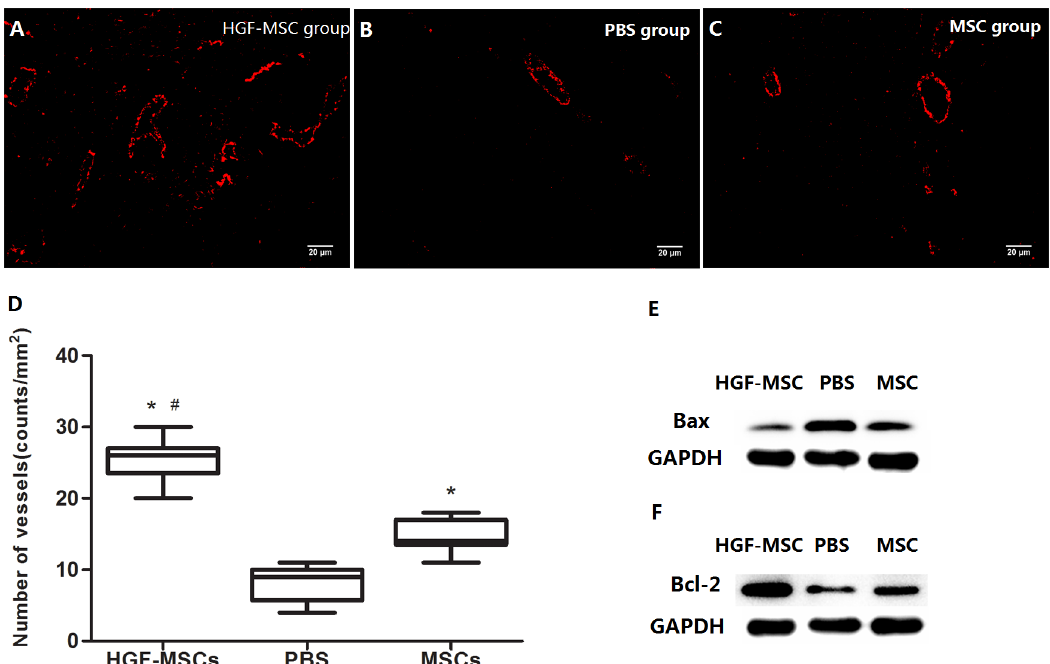
Figure 3. Alterations of vascularization and apoptosis. (A–C) Immunofluorescence staining to detect vascularization (vWF-positive staining) in the different experimental groups. (D) Quantification of the number of vWF-positive vessels at a 400X magnification in the different groups. *, P , 0.01 vs. the PBS group; # , P , 0.01 vs. the MSC group. (E–F) There was a significant decrease in the Bax protein expression level and a significant increase in the Bcl-2 expression level in the HGF-MSC group compared with the other two